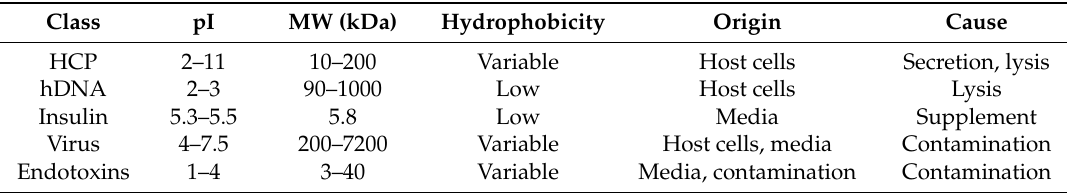
Physicochemical properties of the main impurities during the production of biopharmaceuticals, according to